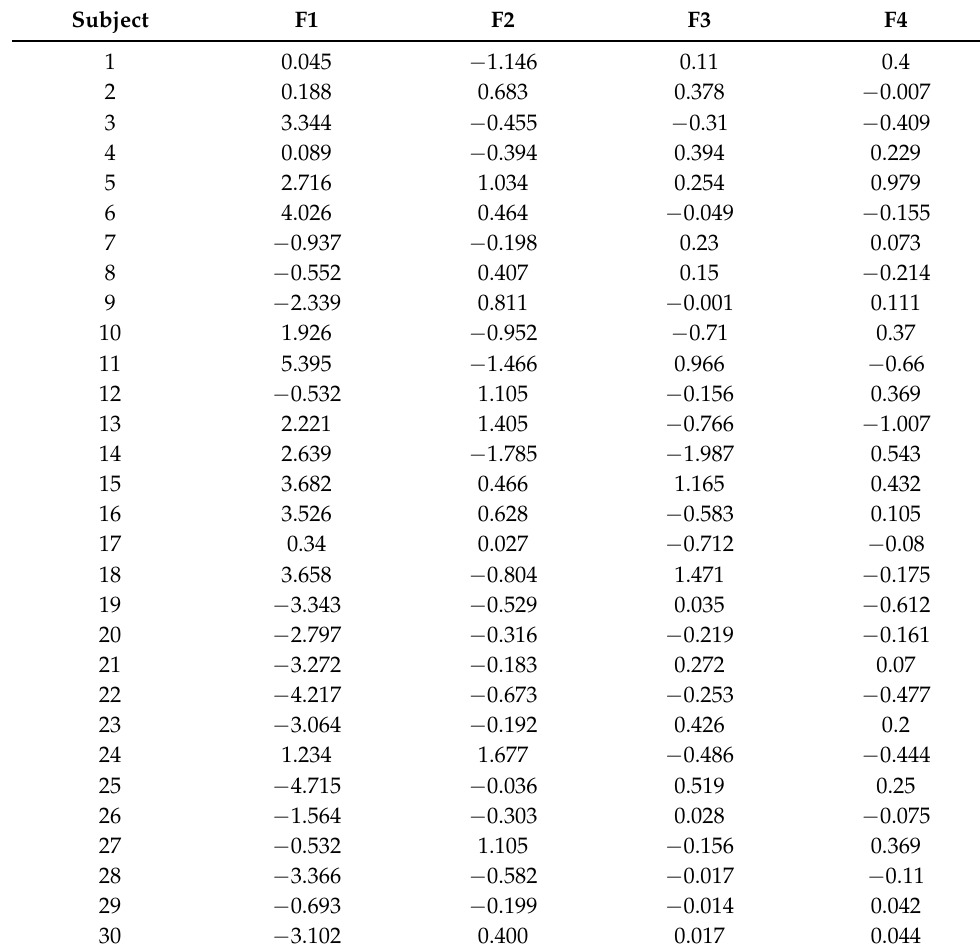
Table 5. Contribution of each mode to the reconstruction of hand forces of